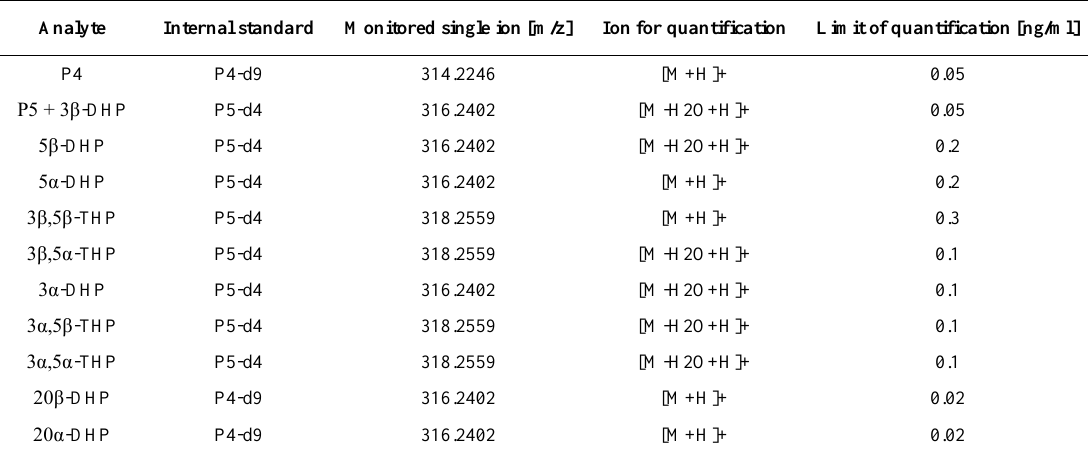
Table 1. Analyzed analytes with their respective internal standard, monitored single ions, ion for